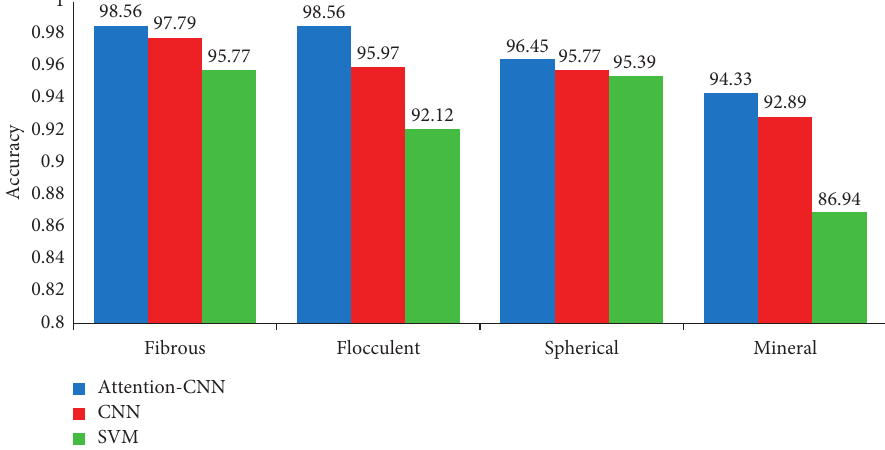
Figure 7: Histogram of classification accuracy of Attention-CNN, CNN, and